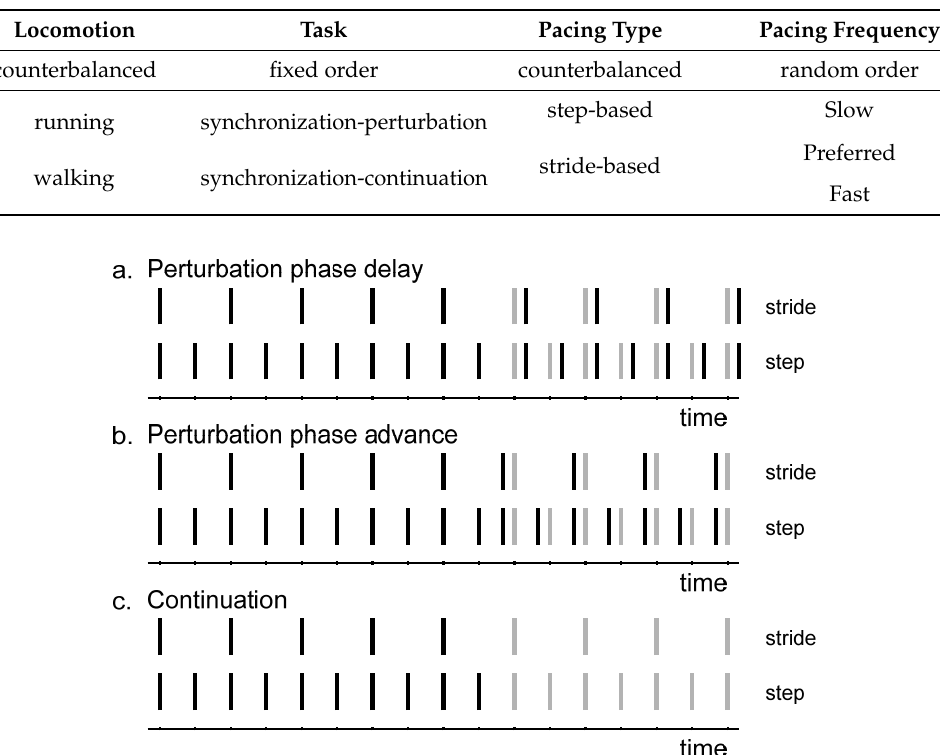
Table 1. Overview of the different conditions and the order of these conditions.